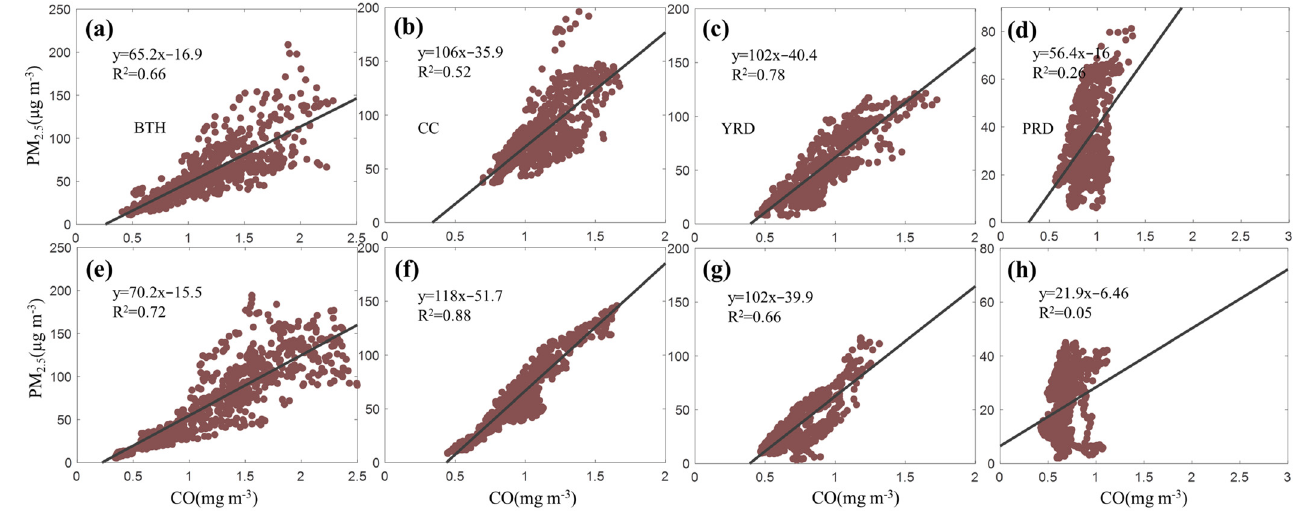
Figure 4. The linear correlations between CO and PM 2.5 mass concentration (µg m − 3 for PM 2.5 and mg m − 3 for CO) in the BTH, the CC, the YRD and the PRD. ( a – d ) FMC_2019. ( e – h ) FMC_2020. In China, nitrate and sulfate are the most important components of secondary particu- late matter in PM 2.5 , which is partly affected by NOx and SO 2 in the air [86,87]. Figure 3c–f shows the spatial distribution of NO 2 mass concentration and SO 2 mass concentration